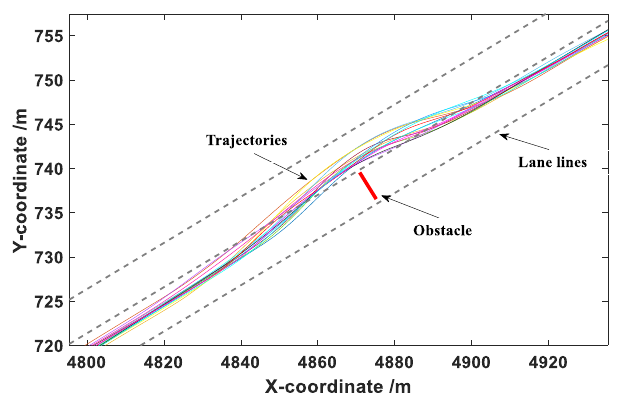
Figure 9. Obstacle avoidance trajectories under a vehicle speed of 40 km/h.